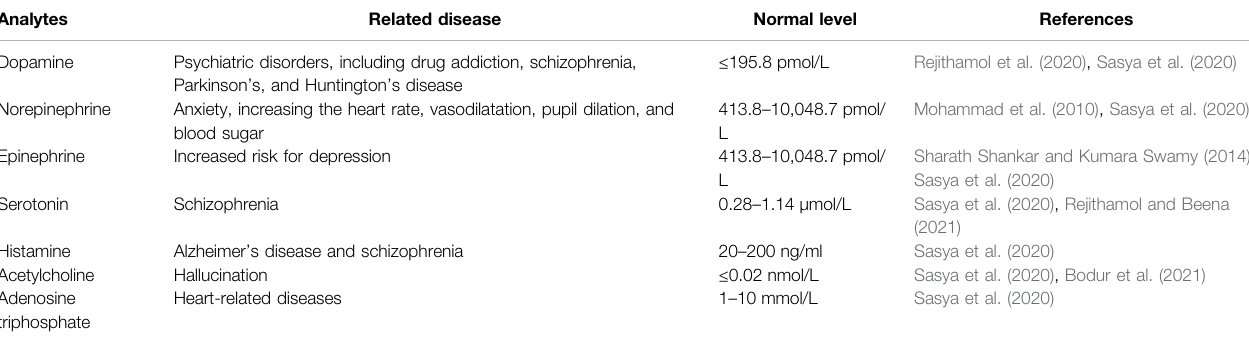
TABLE 1 | Neurotransmitters and their normal range in the human